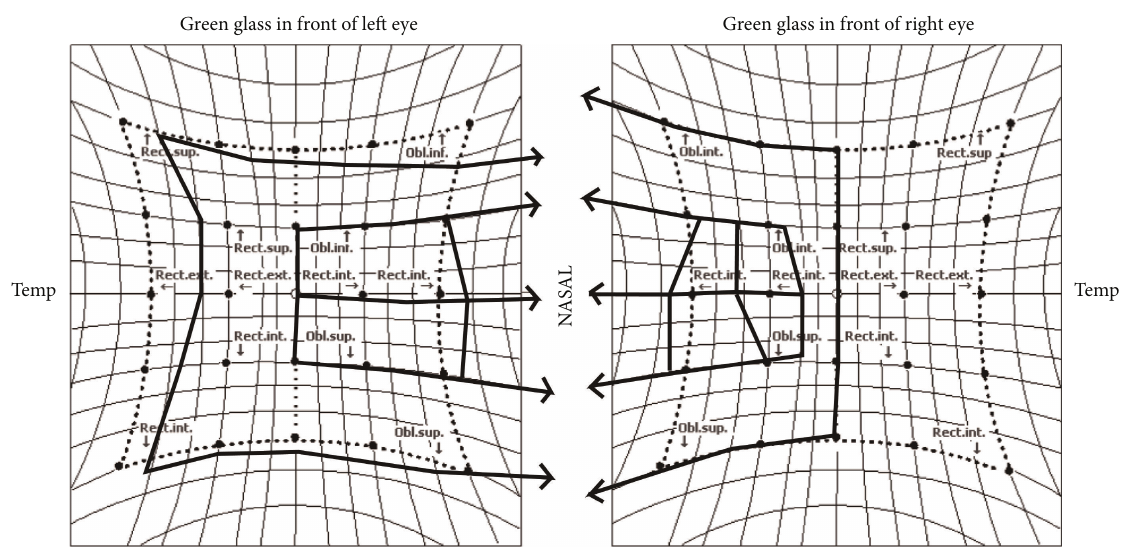
Figure 2: After the 20 PD base-out Fresnel prism, the abduction deficit is noted dominantly in the right